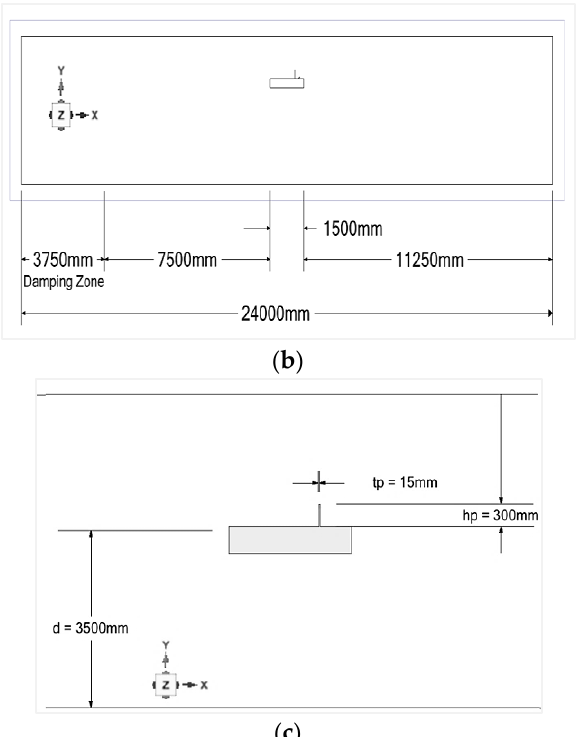
Figure 9. Sketch of the simulation domain (not to scale): ( a ) 3D view of symmetric domain; ( b ) side view of the entire domain; ( c ) closeup view of the box ship model with various dimensions.